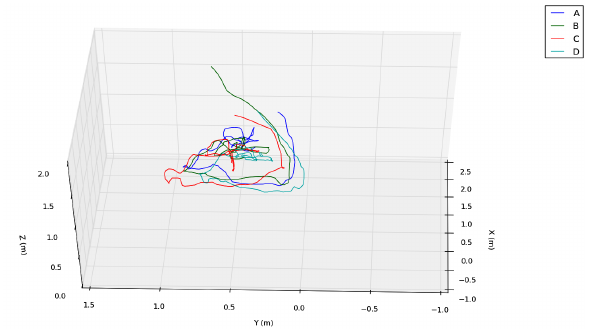
Figure 5: Trajectories of a person as produced by each sensor